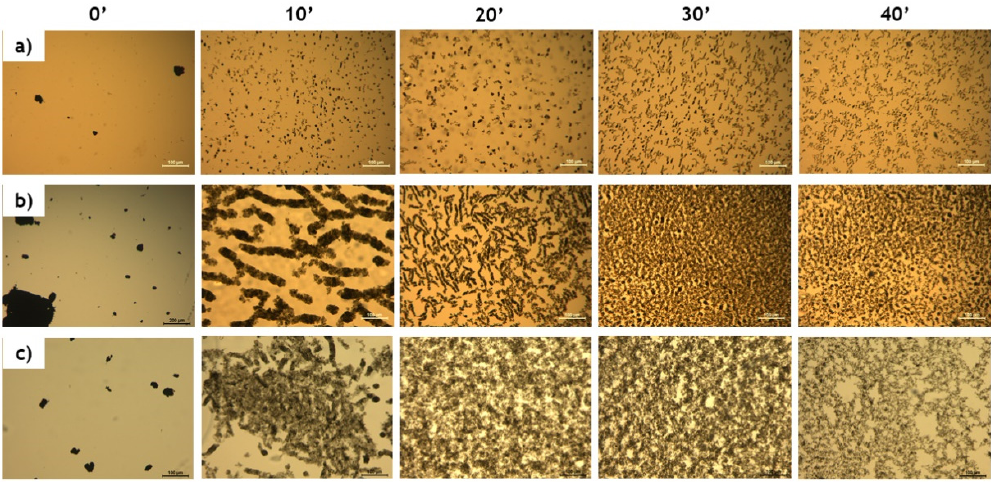
Figure 3. TOM images of the CNT-PEGDGE mixtures as a function of sonication time at ( a ) 0.01, ( b ) 0.05 and ( c ) 0.1 wt.% CNT content.